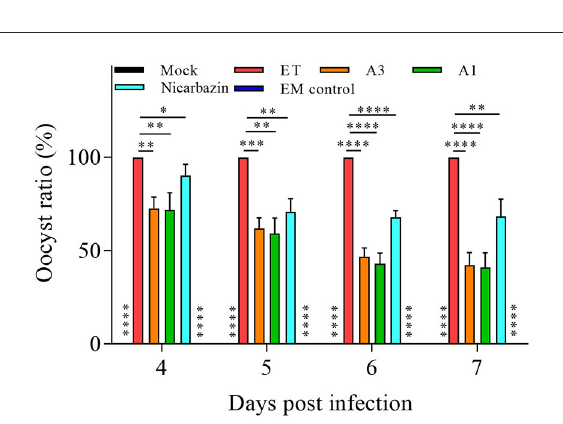
FIGURE7 Evaluation of the oocyst ratio per g of excreta from the chickens in vivo from Day 4–7 p.i. * P < 0.05,** P < 0.01, *** P < 0.005, **** P < 0.001 (each group compared with the ET group). A3 and A1 represent EM treatment 3 days before and 1 day after ET infection, respectively. EM, extract and essential oil mixture (non-toxic concentrations of Punica granatum L.,